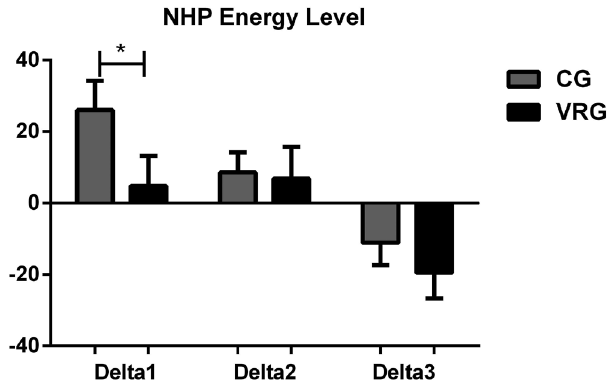
Fig. 5 – Effect of cardiac rehabilitation versus time of post surgical energy level in the field of NHP in CG and VRG. NHP = Nottingham Health Profile; CG = Control Group; VRG = Virtual Reality Group; Delta 1 (difference of pre-operative score for first postoperative day); Delta 2 (difference of pre-operative score for third postoperative day) and Delta 3 (difference of preoperative score for the discharge day). Data were analyzed using two-way ANOVA (Delta 1 *VRG x CG, P<0.05)